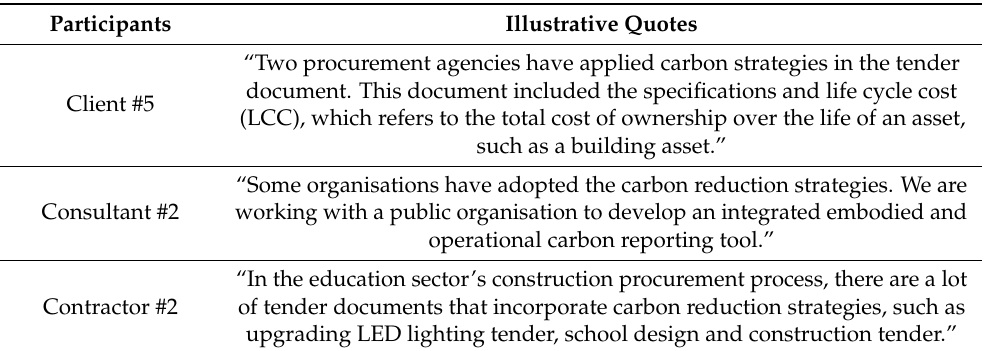
Table 3. The main challenges to reducing carbon emissions in construction procurement mentioned by research